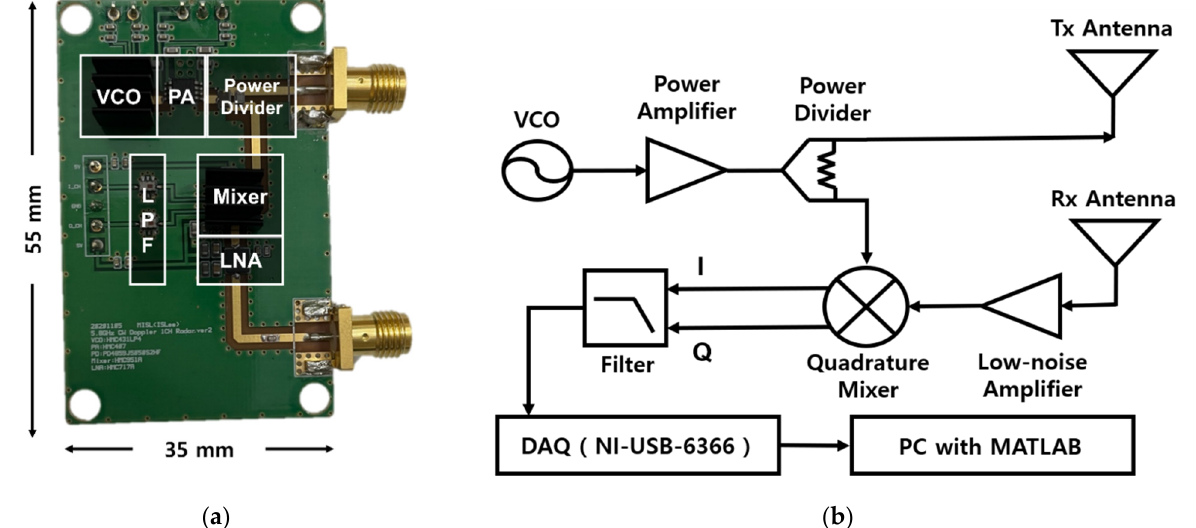
Figure 8. The 5.8 GHz CW radar sensor module: ( a ) photograph of the module implemented on an FR4 PCB; ( b ) block diagram of the module, including antennas, a DAQ board, and a PC.